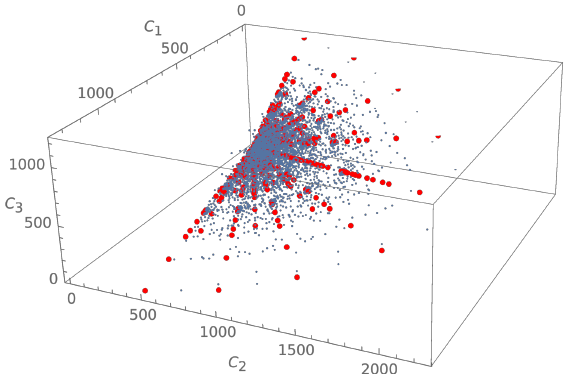
Figure 1 . Distribution of the parameters of the differential operator. Grey points parametrize the 3 -tuples associated to the central charge condition and red points those with vanishing cen- tral